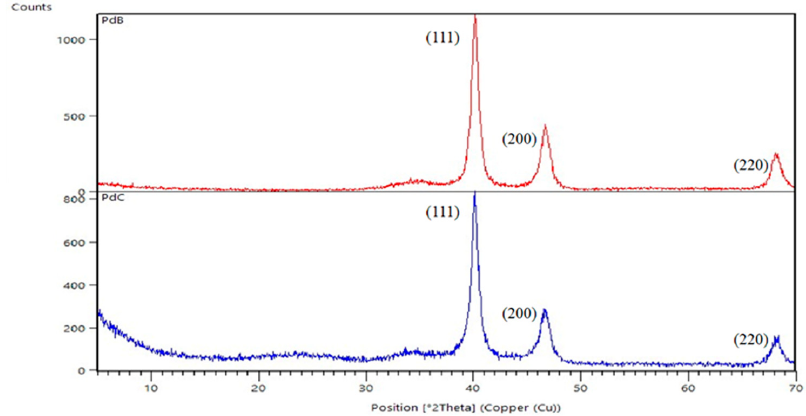
Figure 3. Di ff ractograms of Figure 3. Diffractograms of catalysts.